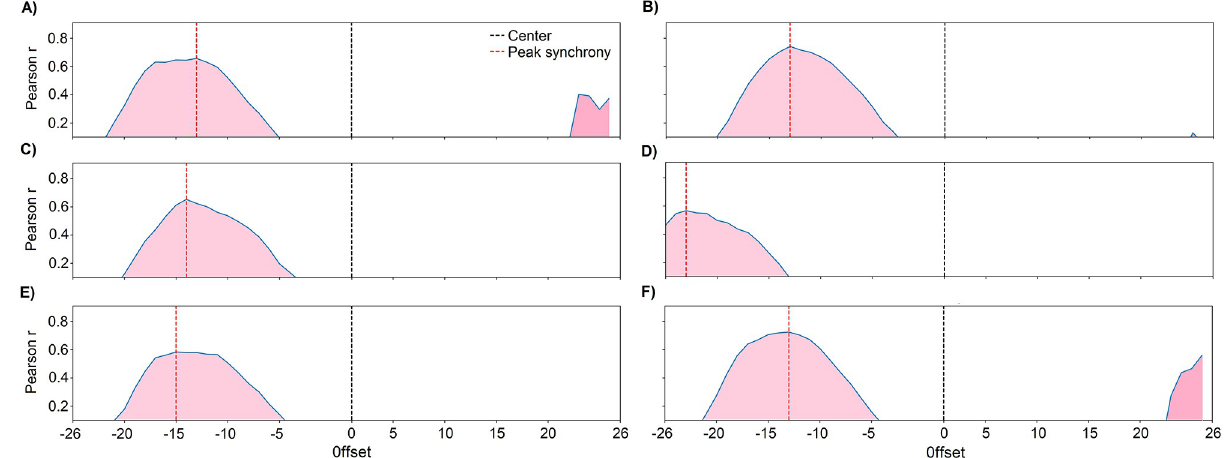
Fig 5. Cross-correlation between temperature and cases: Comas in (A) 2017 and (B) 2020, Lurigancho in (C) 2017 and (D) 2019, Puente de Piedra in (E) 2020, and (F) the total. The vertical red line indicates the point of maximum correlation.